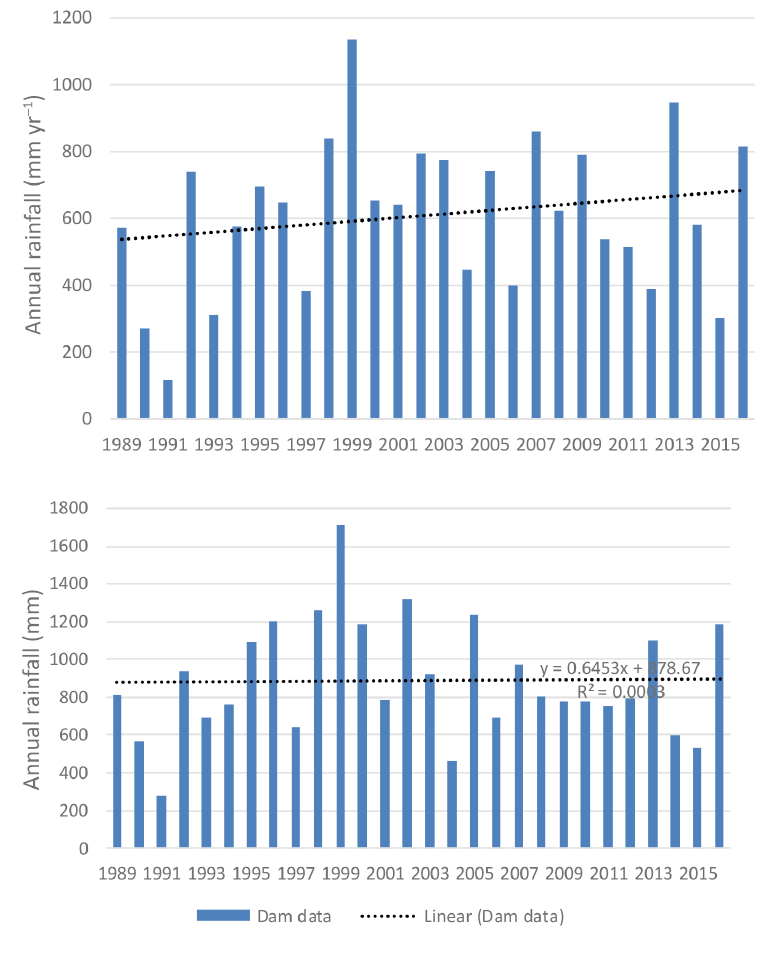
Figure 3. Rainfall trends at Mushandike Irrigation Scheme.